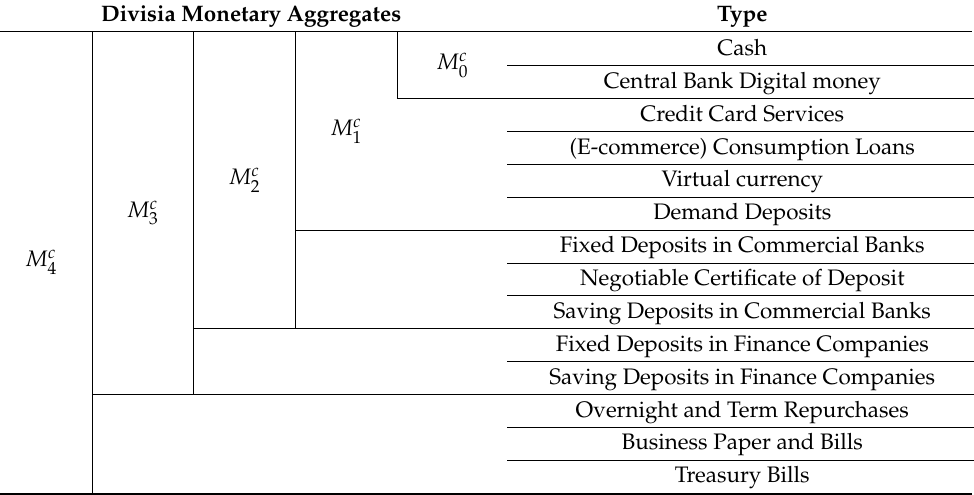
Table 4. Components for New Currency Augmented Divisia Monetary